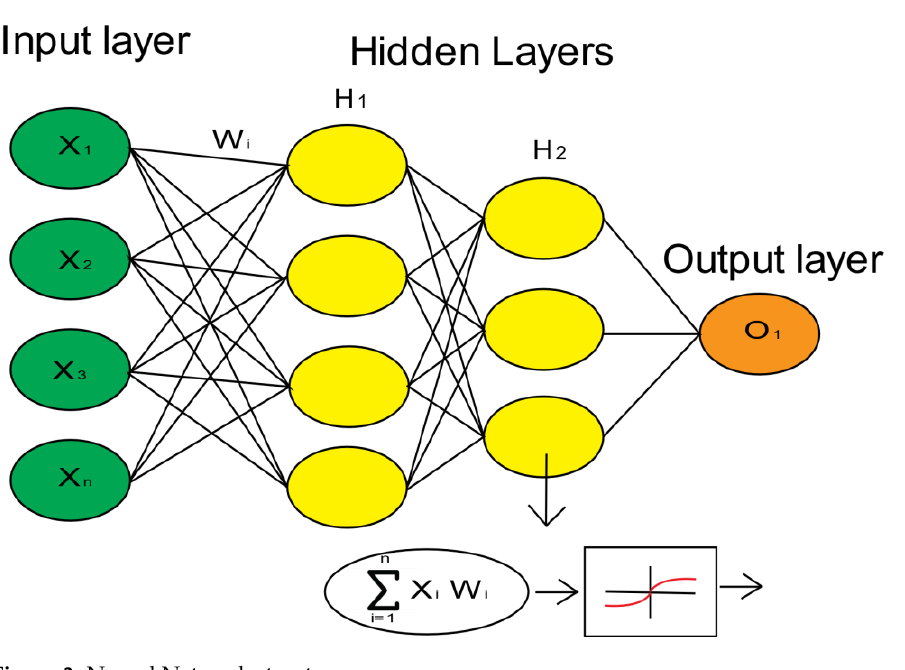
Figure 3. Neural Network structure.